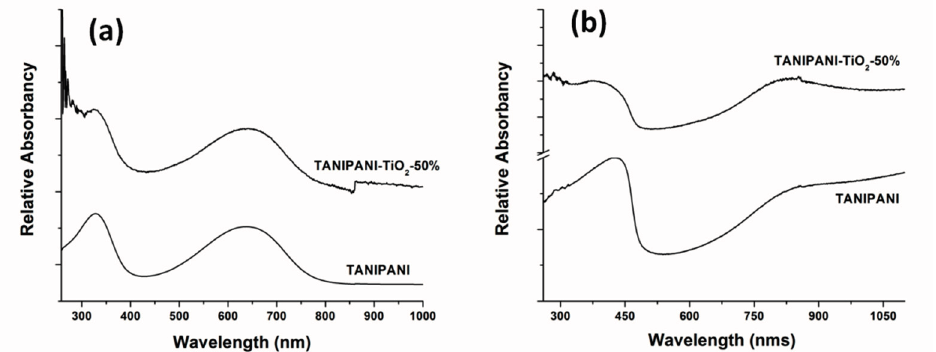
Figure 3. ( a ) UV-Visible absorption spectra of dedoped TANIPANI-TiO 2 and TANIPANI solutions in NMP solvent; ( b ) UV-Visible absorption spectra of doped TANIPANI-TiO 2 and TANIPANI thin films spin coated from m-cresol solvent.